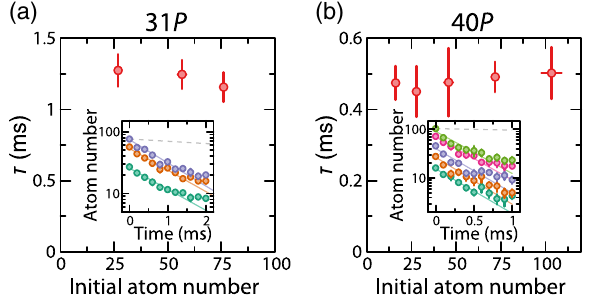
FIG. 8. Dependence of lifetime on atom number at fixed density. (a)Initial lifetime for2Dsystemswith differentinitialatom number dressed to 31 P .Measurementsaremade ina 2Drectangularsystem of small width approximately 4 a and variable length along the latt dressing beam direction. We observe no strong dependence on the atom number. The Rabi frequency is approximately constant over the entire system. For these data, Ω ¼ 2 π × 7 . 02 ð 5 Þ MHz, Δ ¼ 2 π × 60 MHz, and n ¼ 0 . 8 . (b)Sameas in (a) but forsystems dressed to 40 P . For these data, Ω ¼ 2 π × 5 . 6 ð 2 Þ MHz, Δ ¼ 2 π × 40 MHz, and n ¼ 0 . 55 . Insets: raw data with exponen- tial fit to extract the initial decay rate. Experimental error bars correspond to the standard error of the